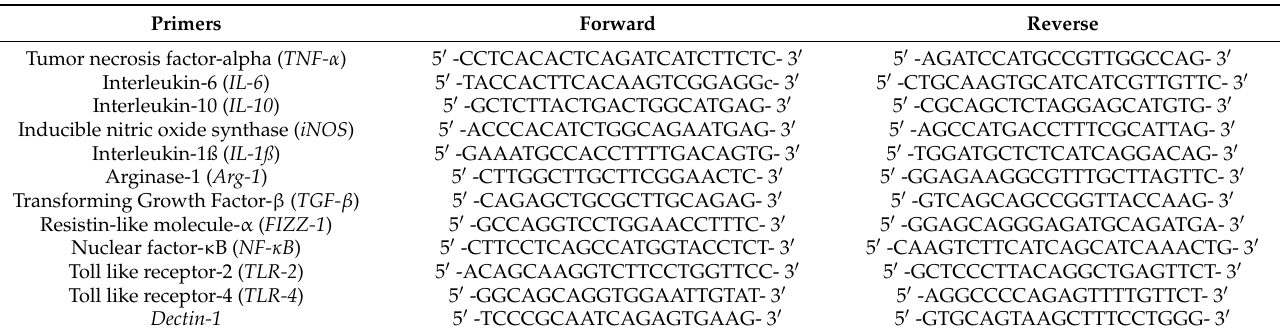
Table 1. List of primers used in the